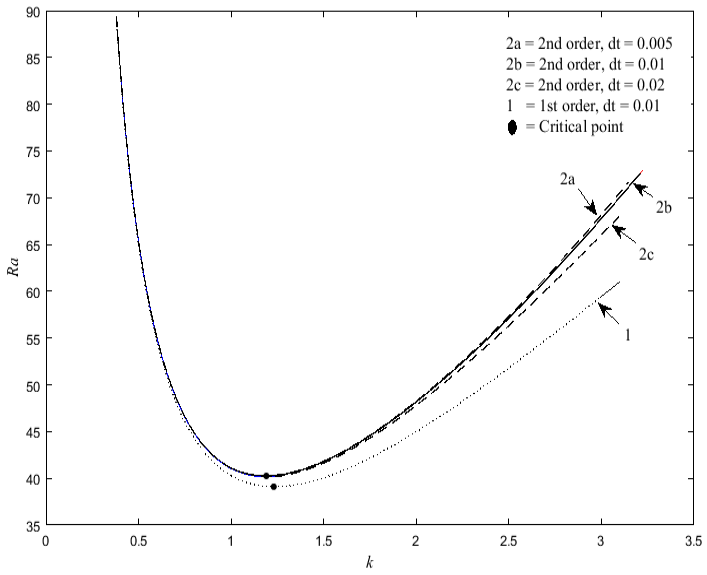
Figure 2. Neutral curves for the first and second order methods for different timesteps.